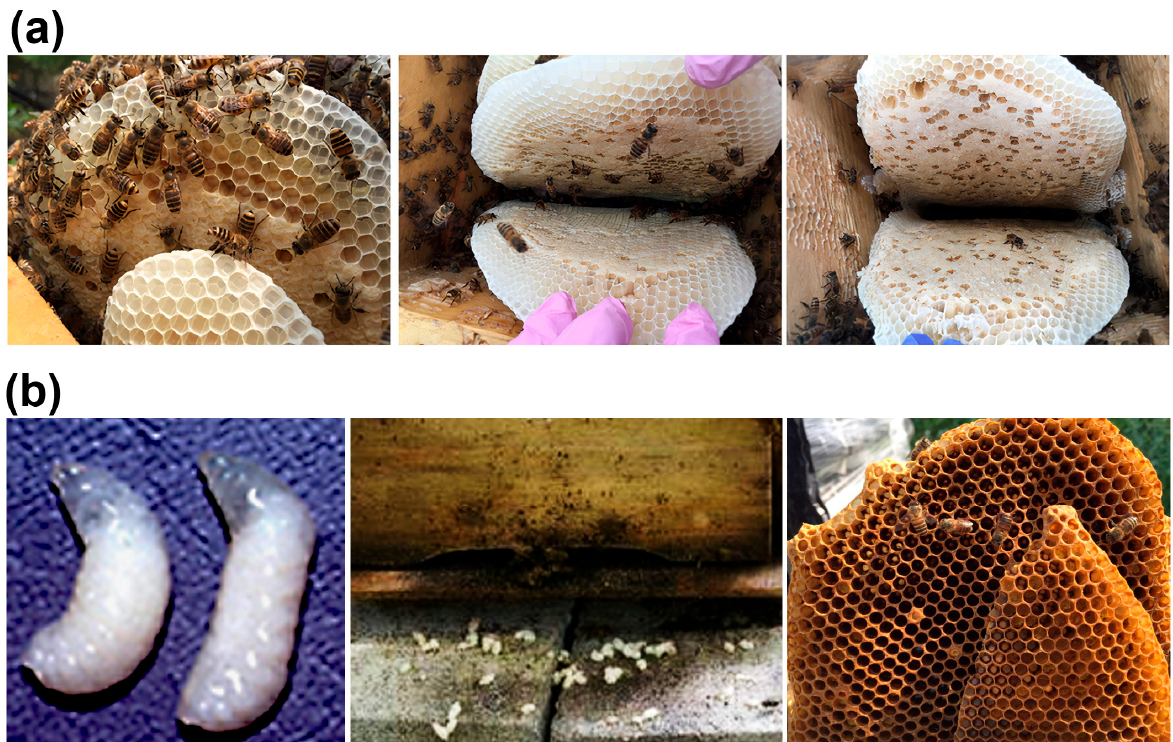
Figure 2. Colonies of Apis cerana after sacbrood virus (SBV) infection and double-stranded RNA (dsRNA) treatment. The SBV-infected colonies were treated with dsRNA five times at 1-week intervals. The treatment resulted in an increase in colony size, with larvae developing into pupae within capping cells and no visible symptoms of the disease within the hives ( a ). Conversely, colonies that did not receive dsRNA treatment exhibited symptoms of SBV disease, including dead larvae with ecdysial fluid visible in the comb, which was removed from the hive by adult nurse bees, and a reduction in the number of adult bees ( b ).